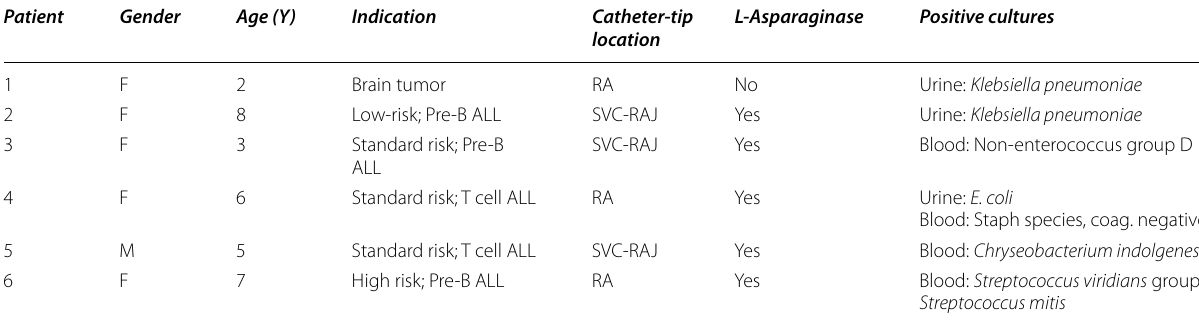
Table 2 Demographic and clinical variables of the CRAT